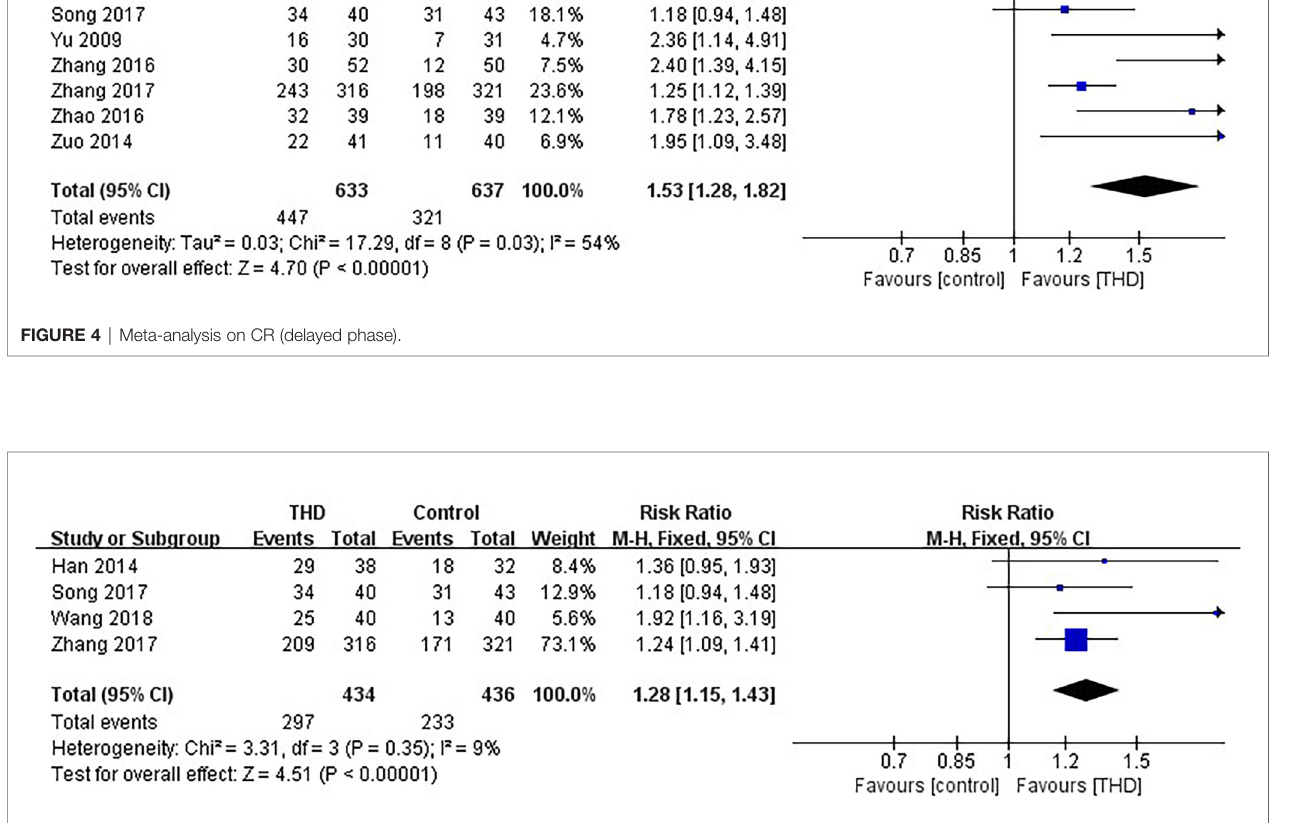
FIGURE 5 | Meta-analysis on CR (overall